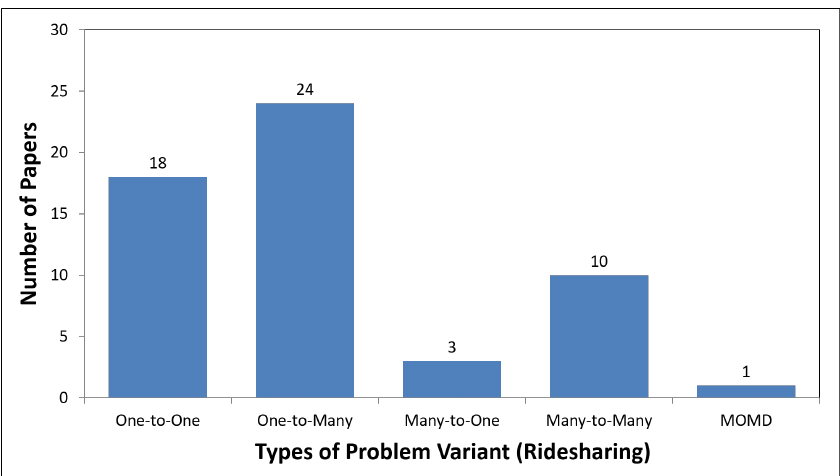
Figure 4. Distribution of Papers based on the Problem Variants: